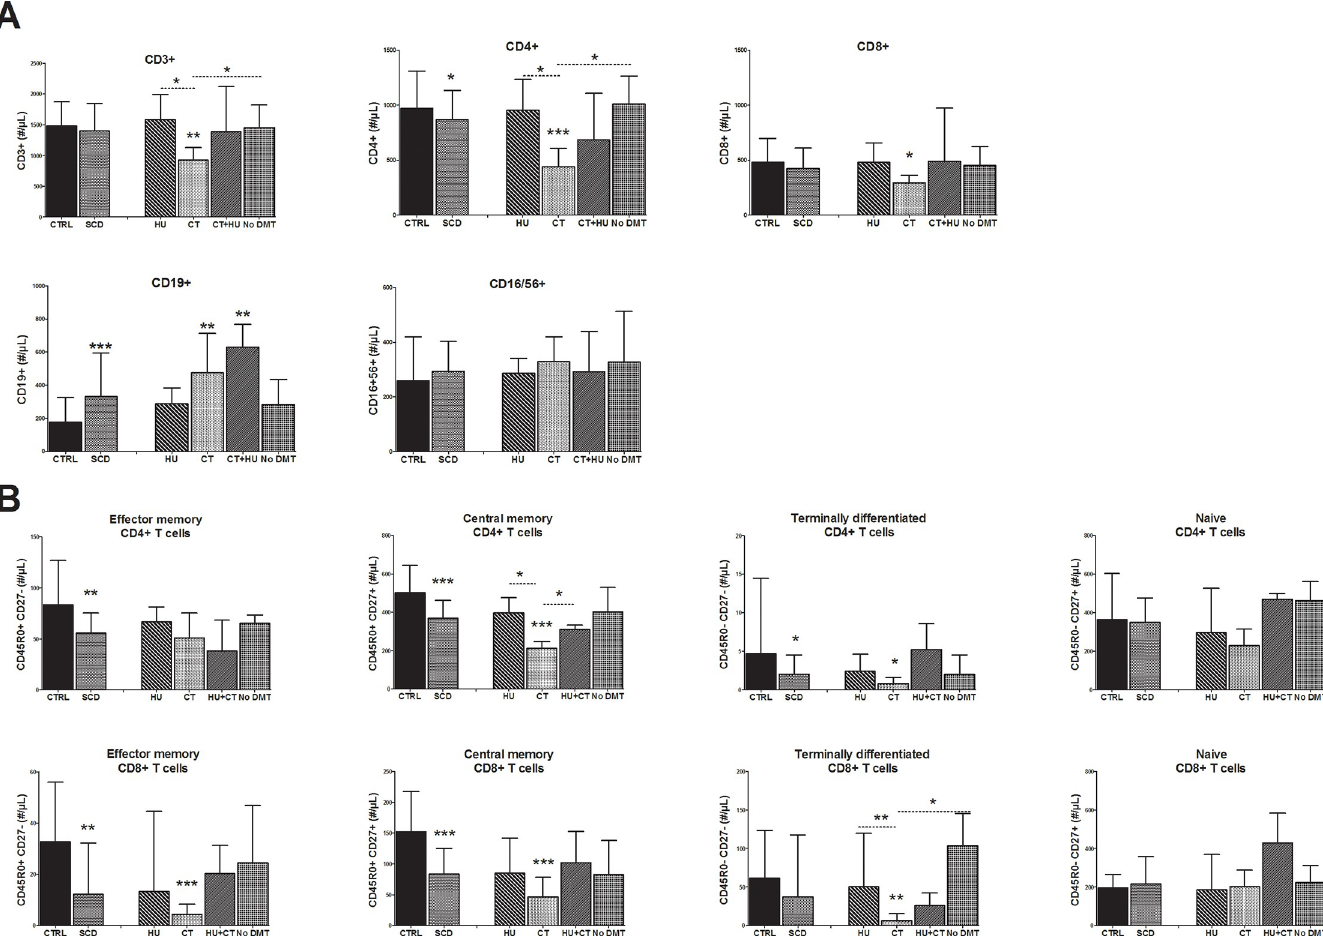
Fig 2. Comparison of lymphocyte cell count in SCD patient treatment groups versus healthy controls. (A) Total CD3 + , CD4 + , CD8 + , CD19 + , CD16/56 + cell counts. (B) CD4 + T cell subpopulations and CD8 + T cell subpopulations cell counts. Comparison between SCD combined groups and healthy control groups were assessed by two tailed nonparametric Mann-Whitney test. Comparison between SCD subgroups according to their treatment and the healthy control group were assessed by the nonparametric Kruskal-Wallis analysis of variance, followed by a Dunn’s multiple comparison test. P-value above bar represent comparison to the healthy control group. Other significant associations are shown. Results of lymphocyte populations are represented as median ± interquartile range (IQR). Results are represented for individuals � 16 years. HU, Hydroxyurea; CT, Chronic transfusion; No DMT, No Disease modifying therapy. � p < 0.05; �� p < 0.01; ��� p < 0.005.